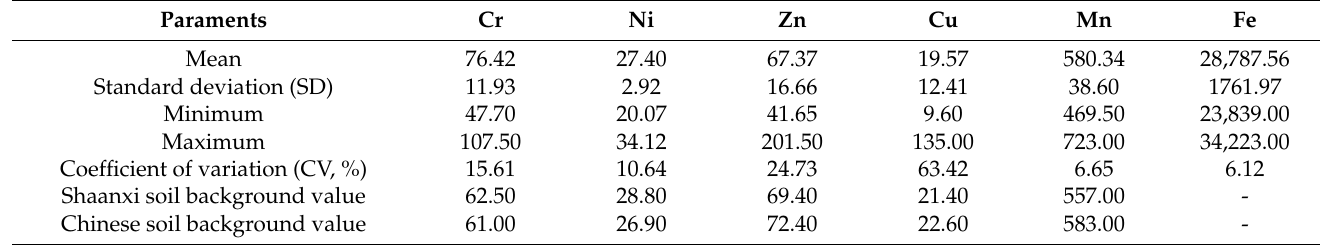
Table 1. Descriptive statistics for soil heavy metals contents of the study area. Unit (mg/kg).